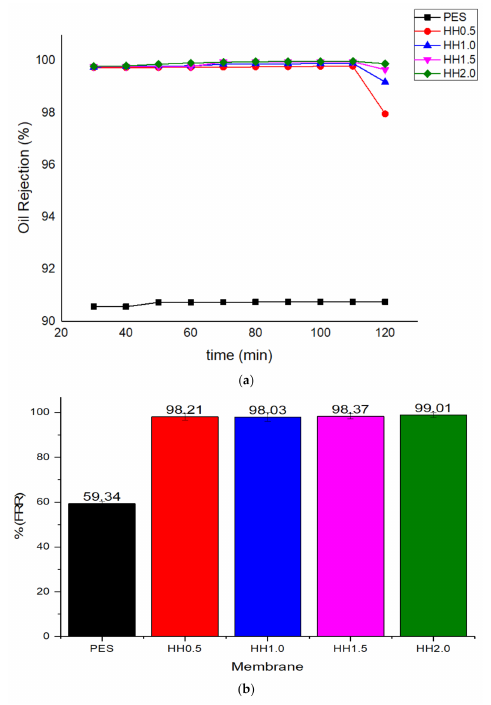
Figure 5. Oil rejection and fouling analysis of the membrane, ( a ) oil rejection percentage over time (%R) and ( b ) the flux recovery rate (FRR) of the pristine PES and the modified